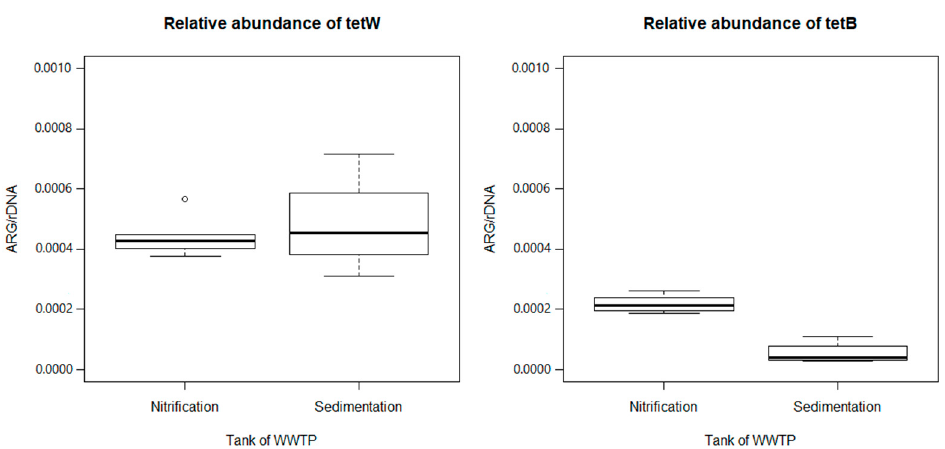
Figure 1. The relative abundance of ARGs ( tet W and tet B) in water samples from the nitrification and sedimentation tanks of wastewater treatment plant (WWTP). Quantity was estimated by real-time PCR and related to the quantity of total bacterial 16S rDNA.